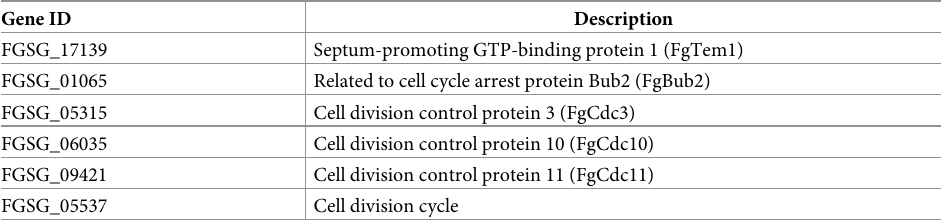
Table 1. List of identified FgTem1-interacting